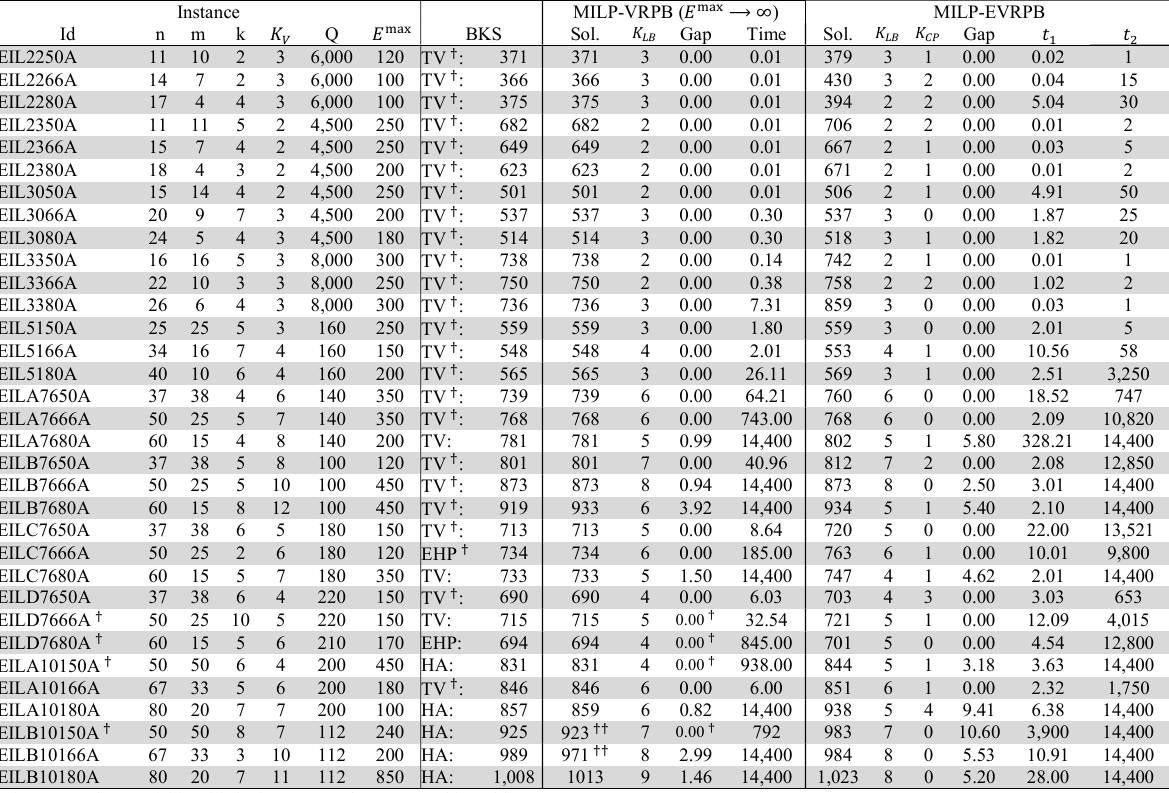
Computational results for the VRPB cases from Toth and Vigo